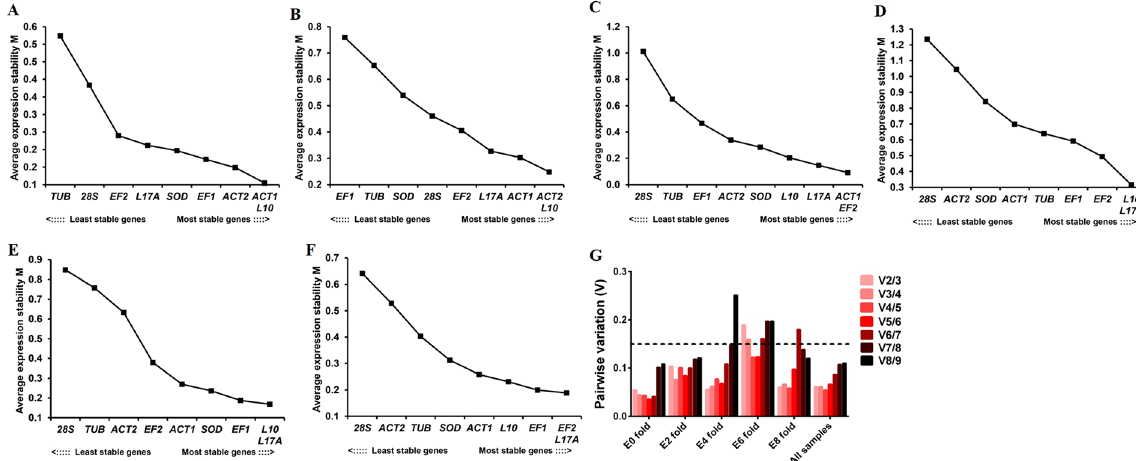
Figure 3. Validation of 9 candidate reference genes with these samples under different concentrations of ascoviruses in S. exigua using geNorm. Virus initial concentration ( A ), virus concentration diluted 100 multiples ( B ), virus concentration diluted 10,000 multiples ( C ), virus concentration diluted 1,000,000 multiples ( D ), virus concentration diluted 100,000,000 multiples ( E ), and all samples set ( F ). ( A , B , C , D , E , F ) represent average expression stability values (M) of 8 candidate genes, and ( G ) shows the determination of the optimal number of candidate genes for normalization by geNorm analysis.